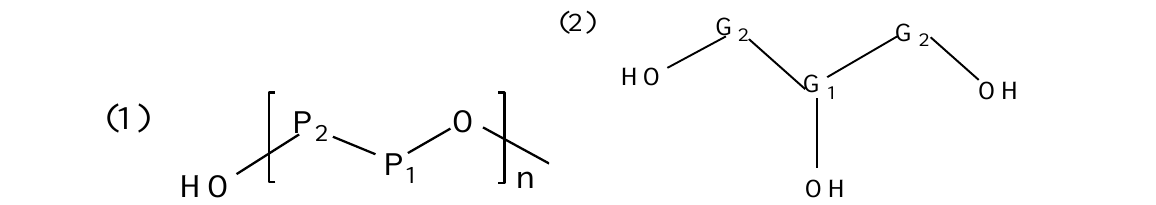
Figure 3. 13 C NMR spectrum of Sample P5.